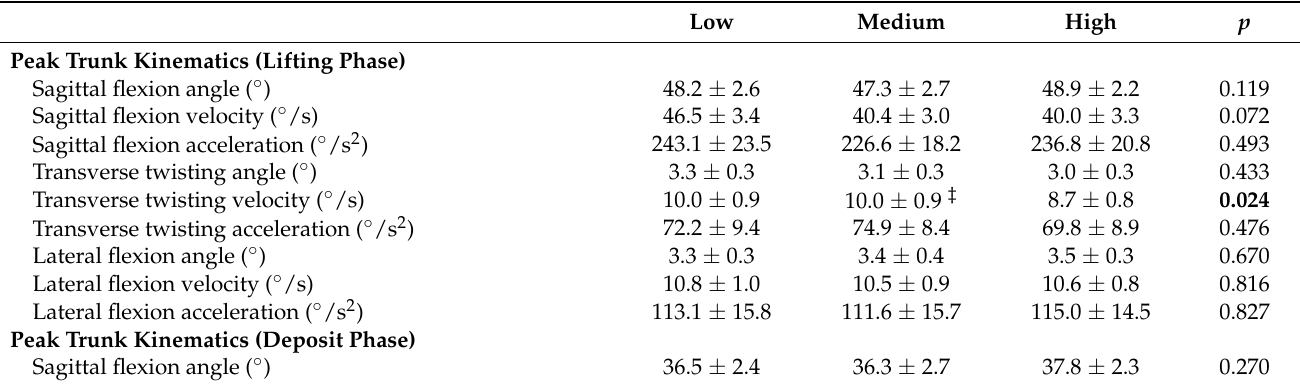
Table 2. Main effects of load weight: Mean ±